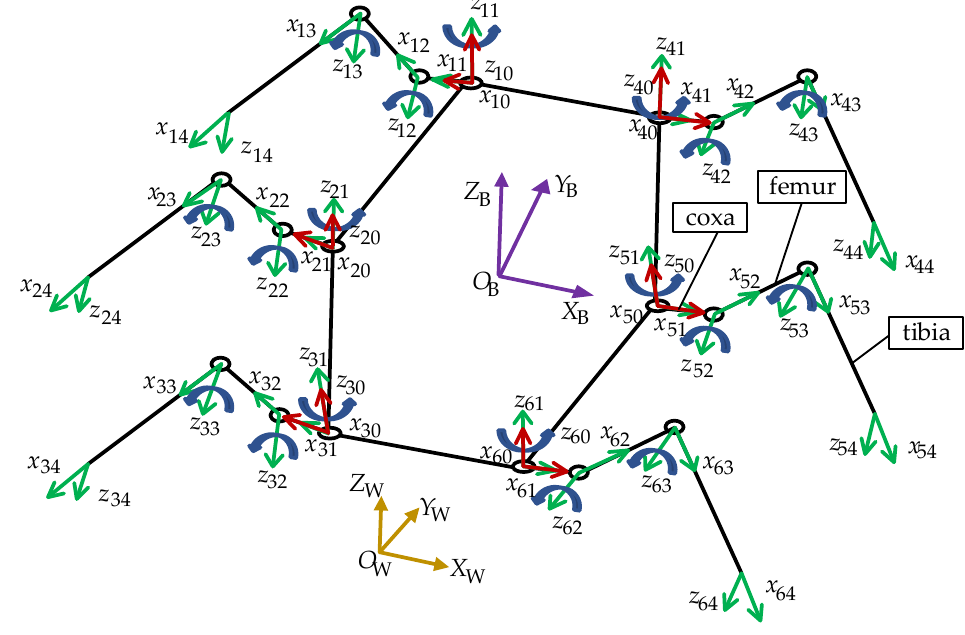
Figure 2. The simplified prototype of hexapod and coordinate systems. Figure 2. The s implified prototype of hexapod and coordinate systems.